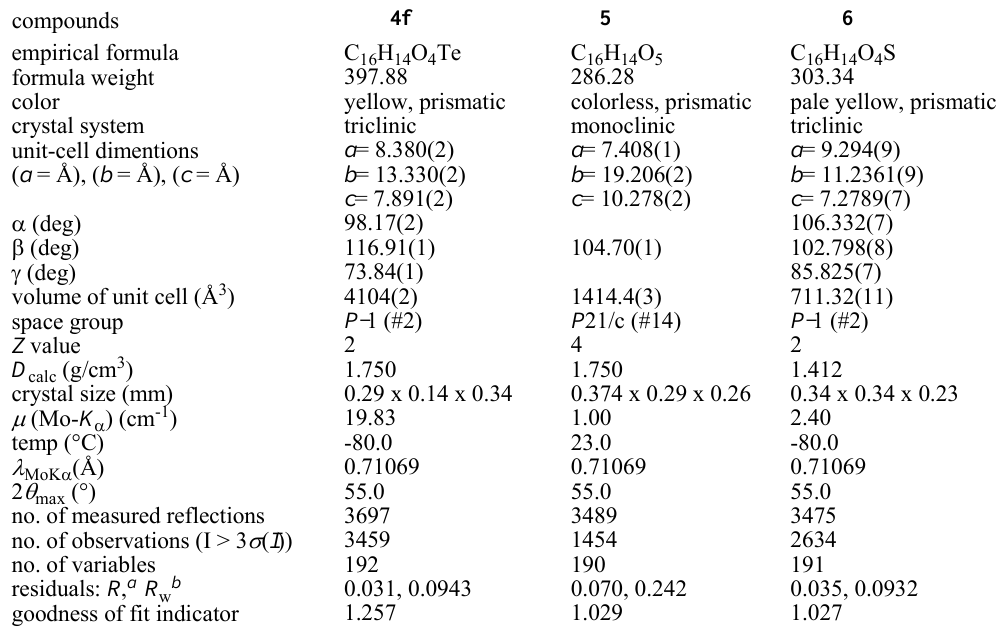
Table 1. Crystal date and data collection of bis(2-methoxybenzoyl) telluride ( 4f ) [8], 2- methoxybenzoic anhydride ( 5 ) [8], and bis(2-methoxybenzoyl) sulfide ( 6 ) [8].